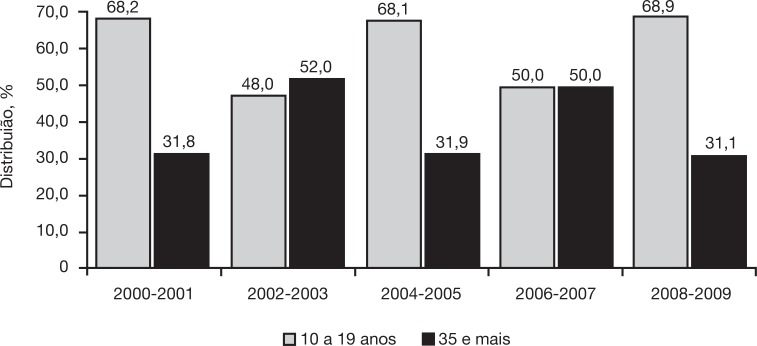
Distribuição dos extremos de idade materna por biênio, 2000 a 2009,
Londrina, PR